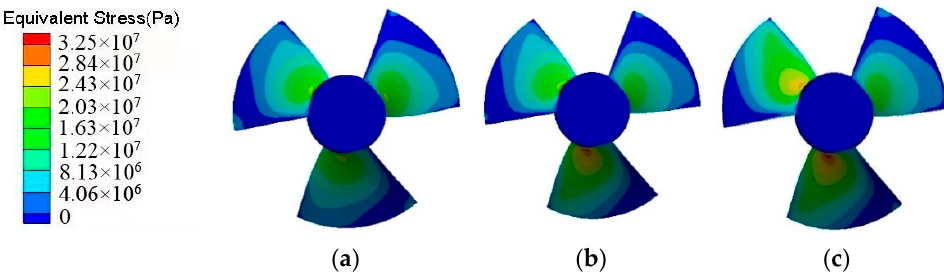
Figure 20. Equivalent stress distribution under Q des in different schemes. ( a ) Scheme I. ( b ) Scheme II. ( c ) Scheme III. Table 4. Maximum equivalent stress of pump blades under different working conditions of each scheme.